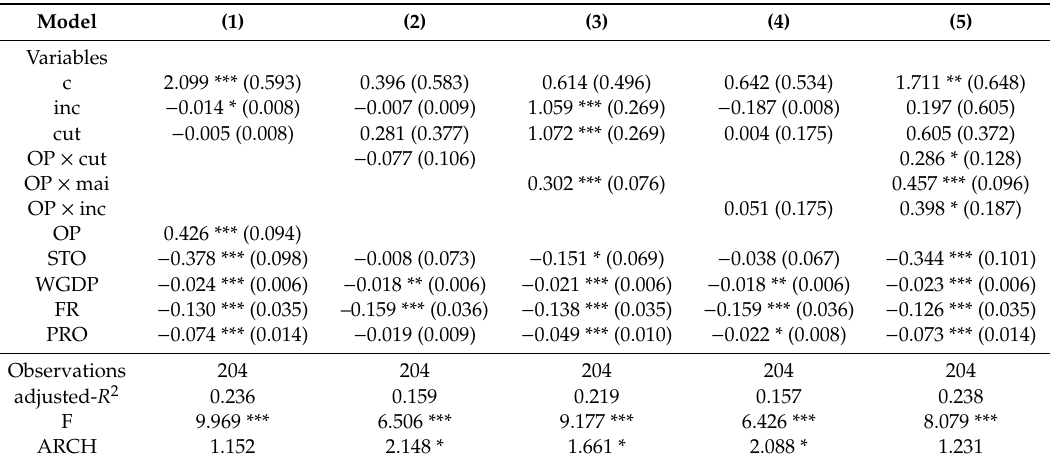
Table 3. Estimation